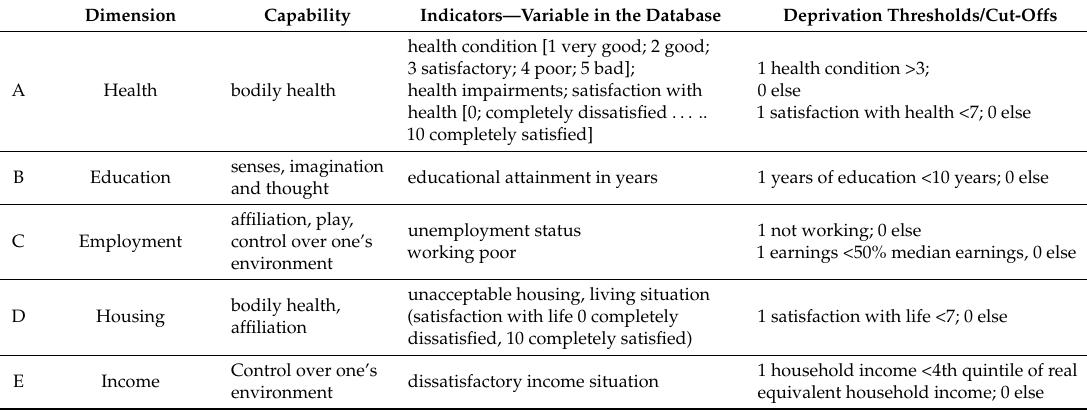
Table 1. Capability Dimensions, indicators, and deprivation